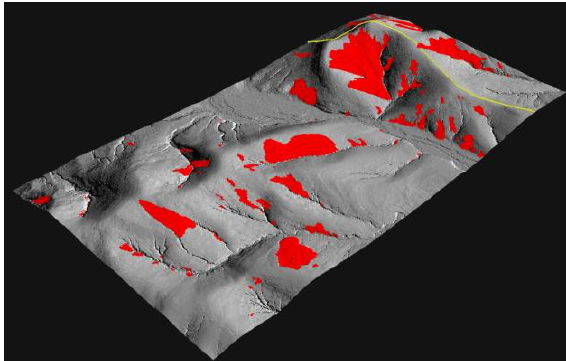
Fig.3a. Spatial view on the landslides.